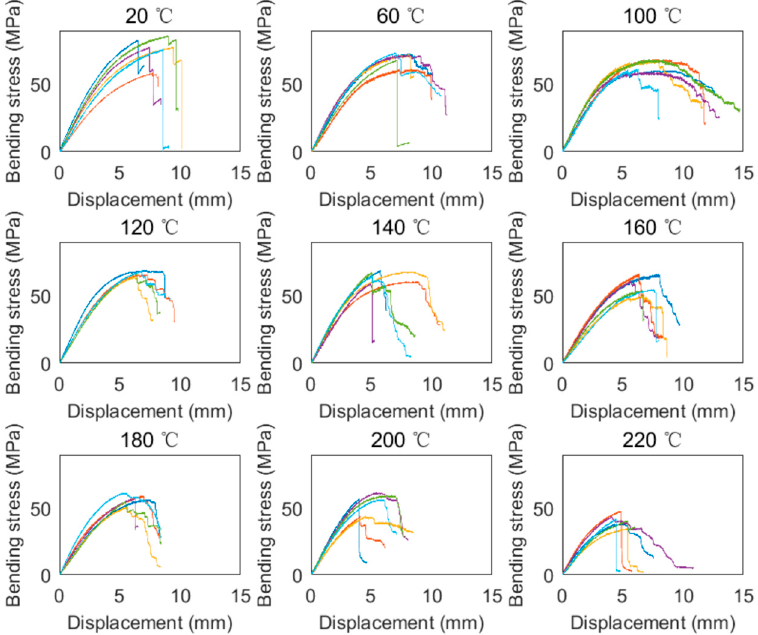
Figure 5. Temperature-dependent moisture content of the wood.